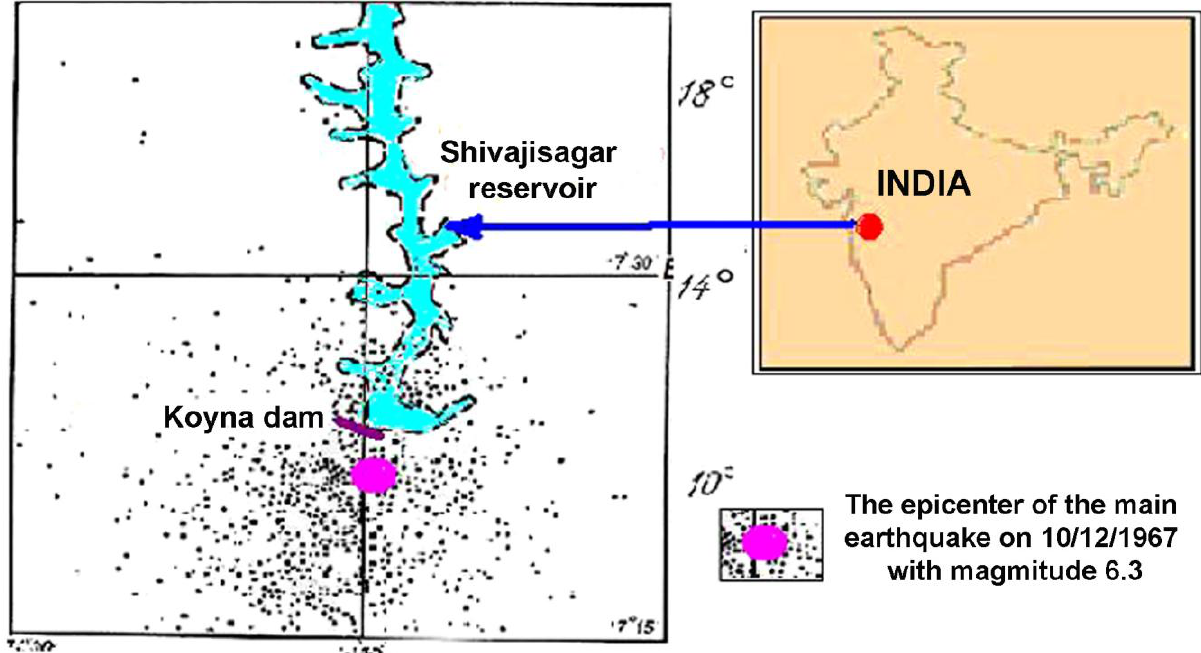
Fig. 1. Epicenters of earthquakes near Shivajisagar reservoir (India) for the period from 10 December 1967 to 31 December 1971 (after Gupta & Rastogi,